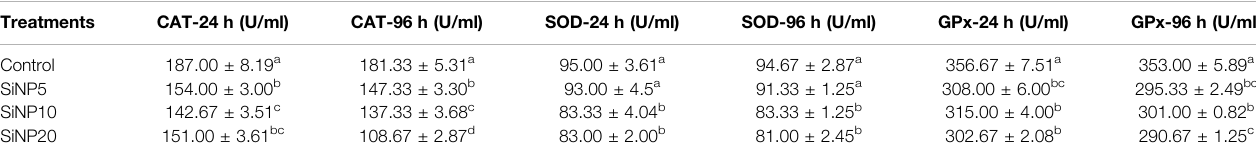
Values represent mean ± SD ( n = 3). Different letters in the same column indicate signi fi cant difference ( p <